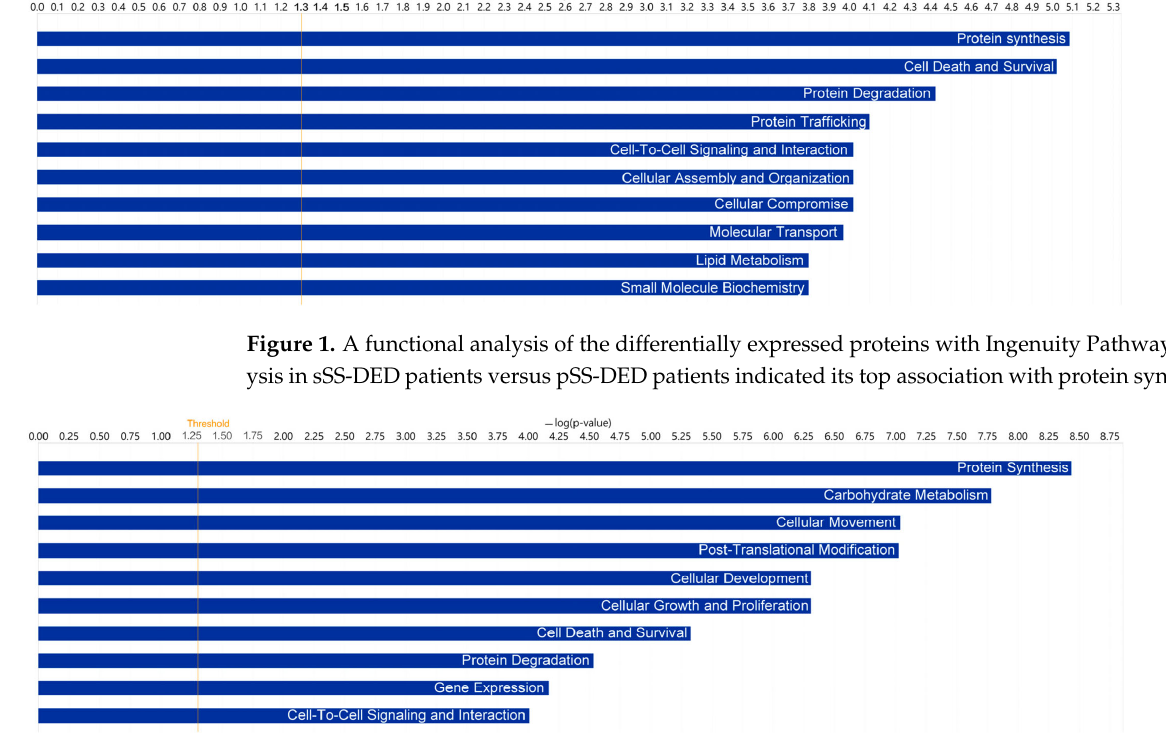
Figure 4. Connections and interactions identified between the 29 candidate proteins using Ingenu ‐ ity Pathway Analysis. Individual nodes are hidden. 2.5. Verification of Candidate Biomarkers We performed an enzyme ‐ linked immunosorbent assay (ELISA) analysis using 1 μ L tear sample from each DED patient to verify four candidate proteins from the proteomics data. As a result, ADAM10 was confirmed to be consistent with the alterations in the proteomics data, which not only showed significance upon comparing among the three groups ( p = 0.018), but also resulted in a significant linear trend ( p = 0.011). After Tukey correction, both comparisons revealed significance (sSS ‐ DED vs. non ‐ SS ‐ DED, p = 0.028; sSS ‐ DED vs. pSS ‐ DED, p = 0.043). Based on ELISA quantification, EGF also showed sig ‐ nificance when comparing among the three groups ( p = 0.023), with significance found between sSS ‐ DED and pSS ‐ DED ( p = 0.02) after the post ‐ hoc test (Table 4).